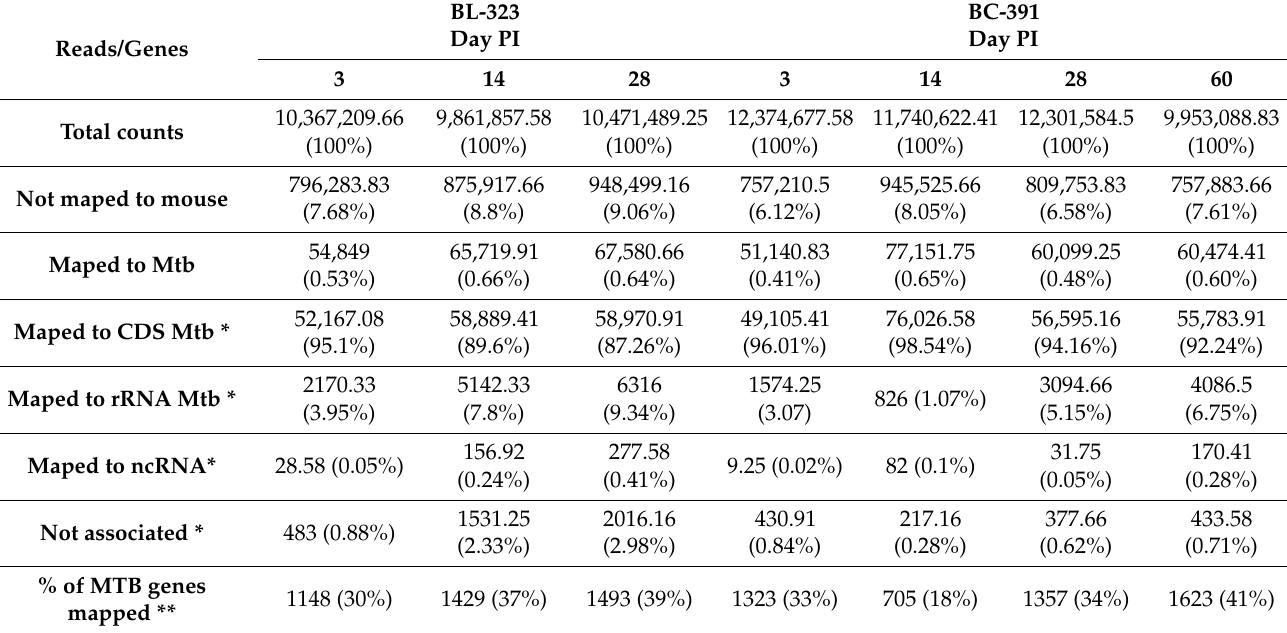
Table 1. Mapped reads to BL-323 and BC-391 genomes and genome